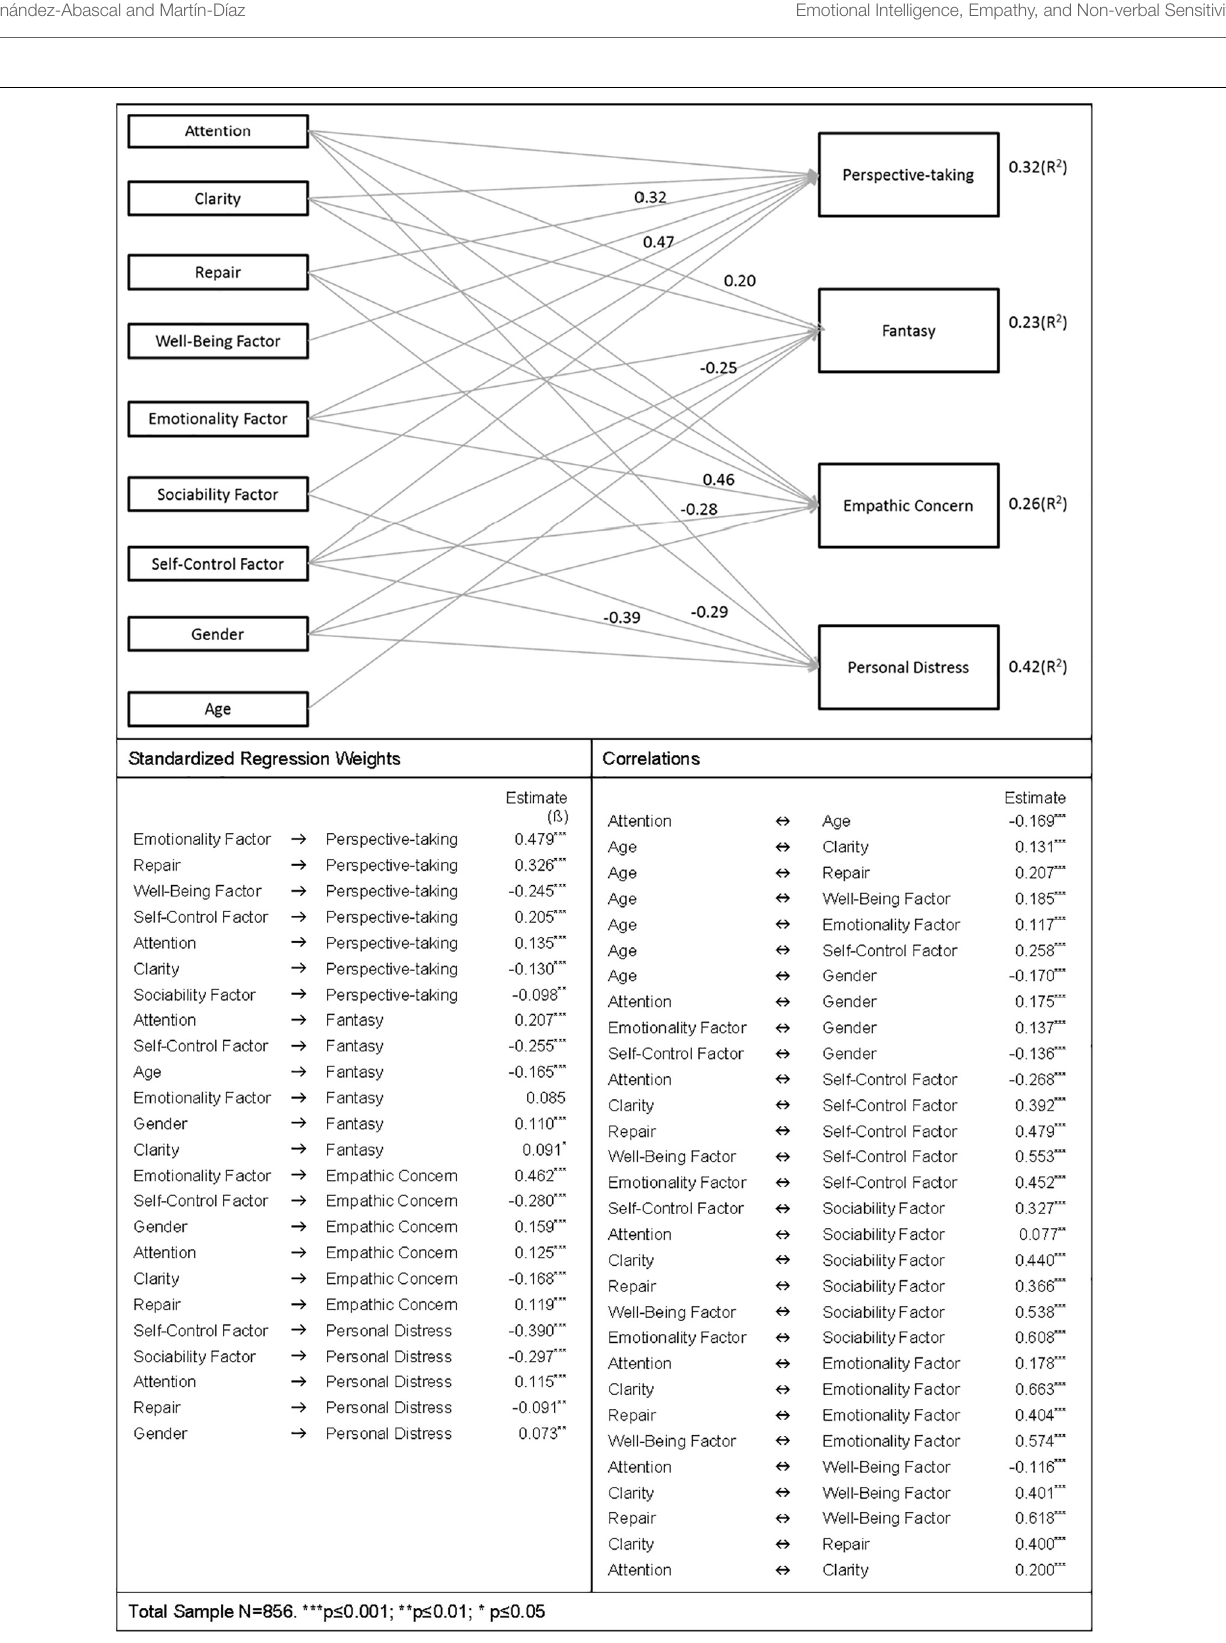
FIGURE 1 | Model indicating standardized solutions and the most relevant